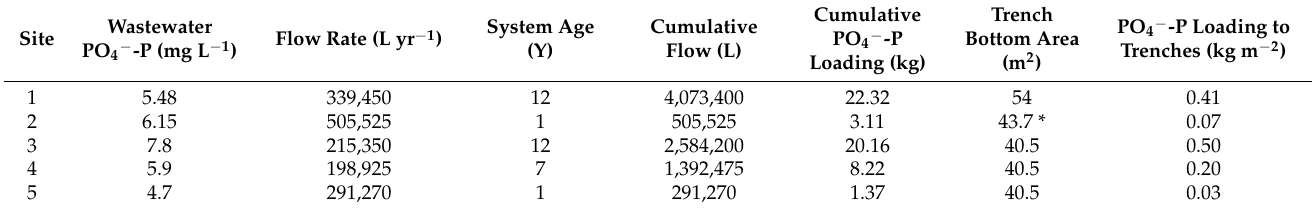
Table 3. Cumulative loading (kg) and loading rates (kg m − 2 ) of PO 4 − -P to soil at Sites 1–5.